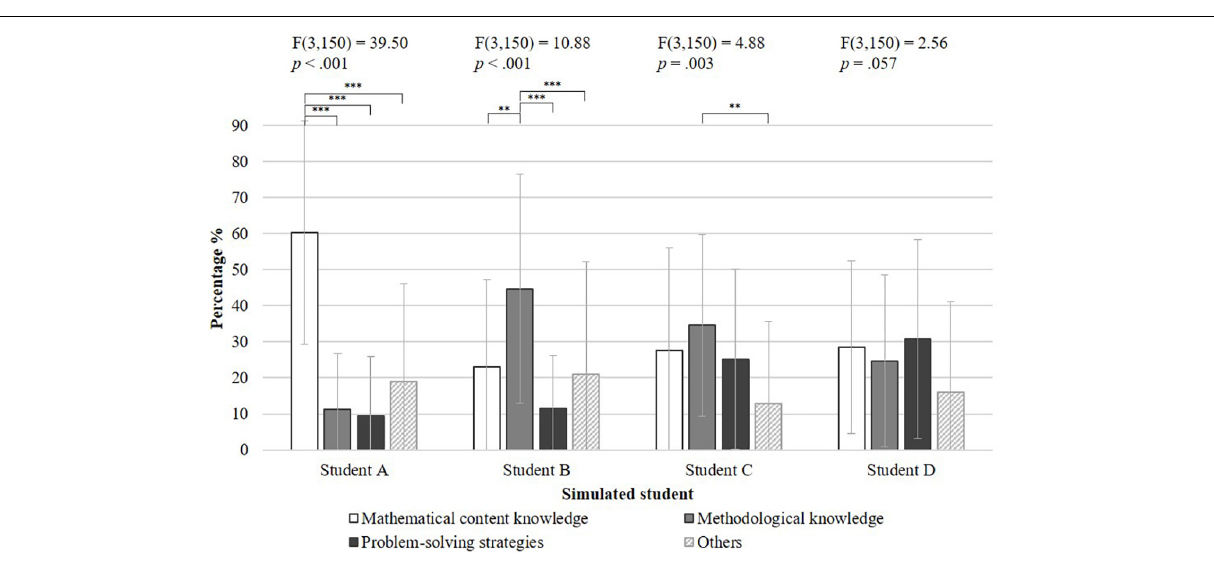
FIGURE 5 | Differences in the noticed prerequisites of the four simulated students with the following significance levels: ** p < 0.01 and *** p <